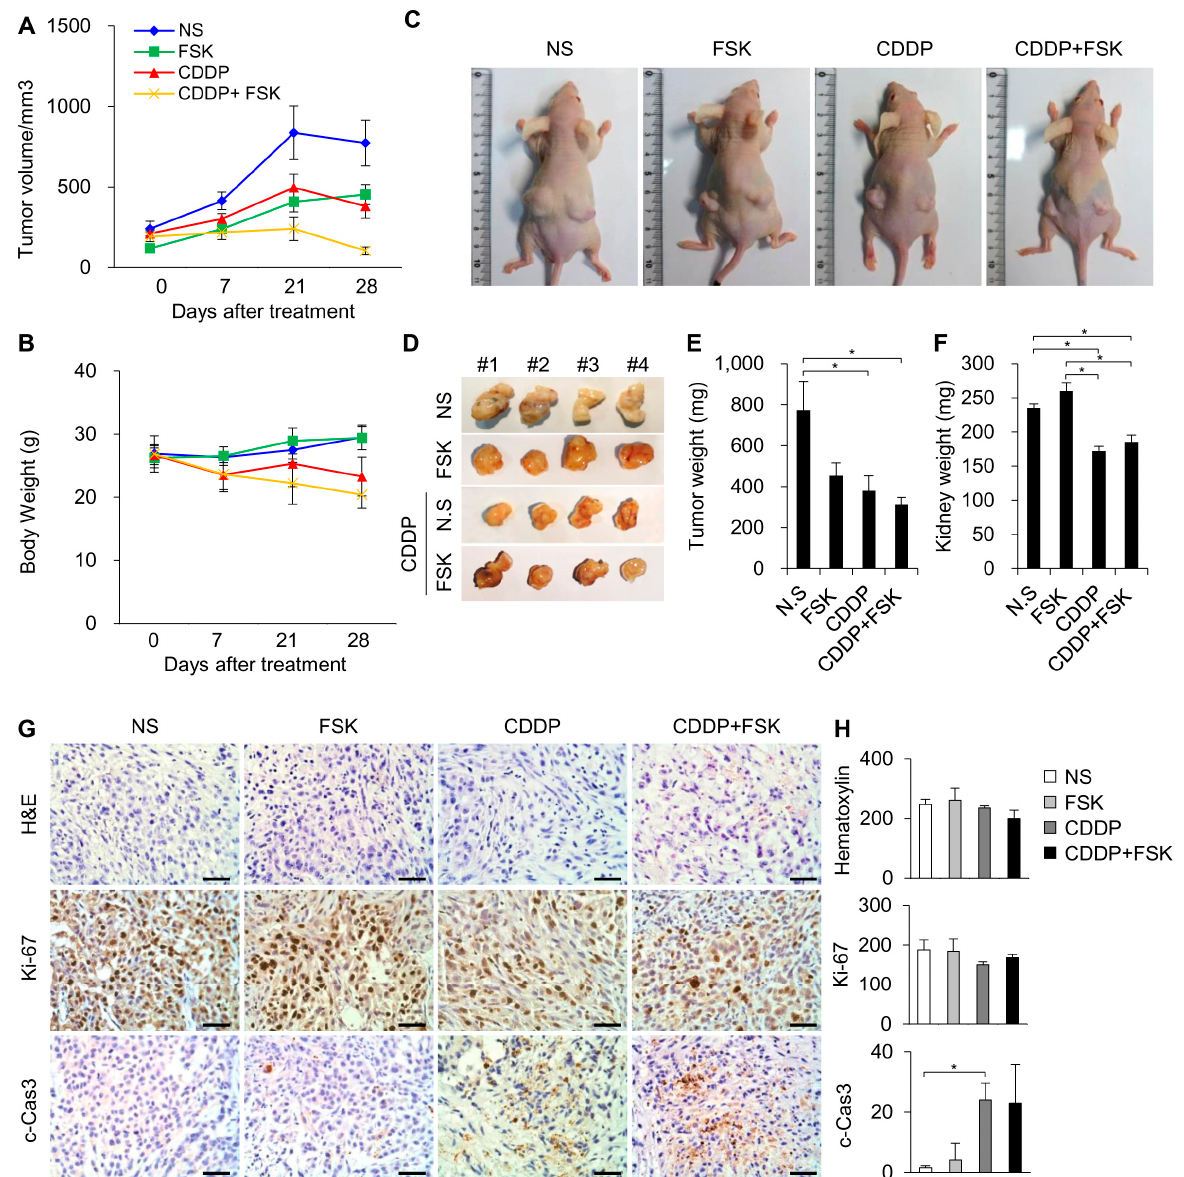
Figure 6. FSK does not inhibit the anti-tumor effects of CDDP in nude mice with lung cancer cell xenografts. Tumor volume ( A ) and body weight ( B ) curves for each group during drug treatment (n = 6 mice per group). ( C ) Representative mice. ( D ) Dissected tumor. Tumor ( E ) and kidney ( F ) weights after sacrifice. The bar graphs show the average tumor and kidney weights ± standard deviation in each group. ( G ) Representative images of tumors from the mice treated with NS and FSK with or without CDDP. Tumor sections were stained with hematoxylin and eosin, Ki-67, and cleaved caspase-3. The brown stained cells represent the positive cells for Ki-67 and cleaved caspase-3, which are counterstained with hematoxylin. ( H ) Quantitative analysis of hematoxylin, Ki-67, and cleaved caspase-3-positive cells in six random fields of view. The bar graph shows mean ± standard deviation. Scale bar = 40 μ m. Differences of * p < 0.05 were considered statistically significant.